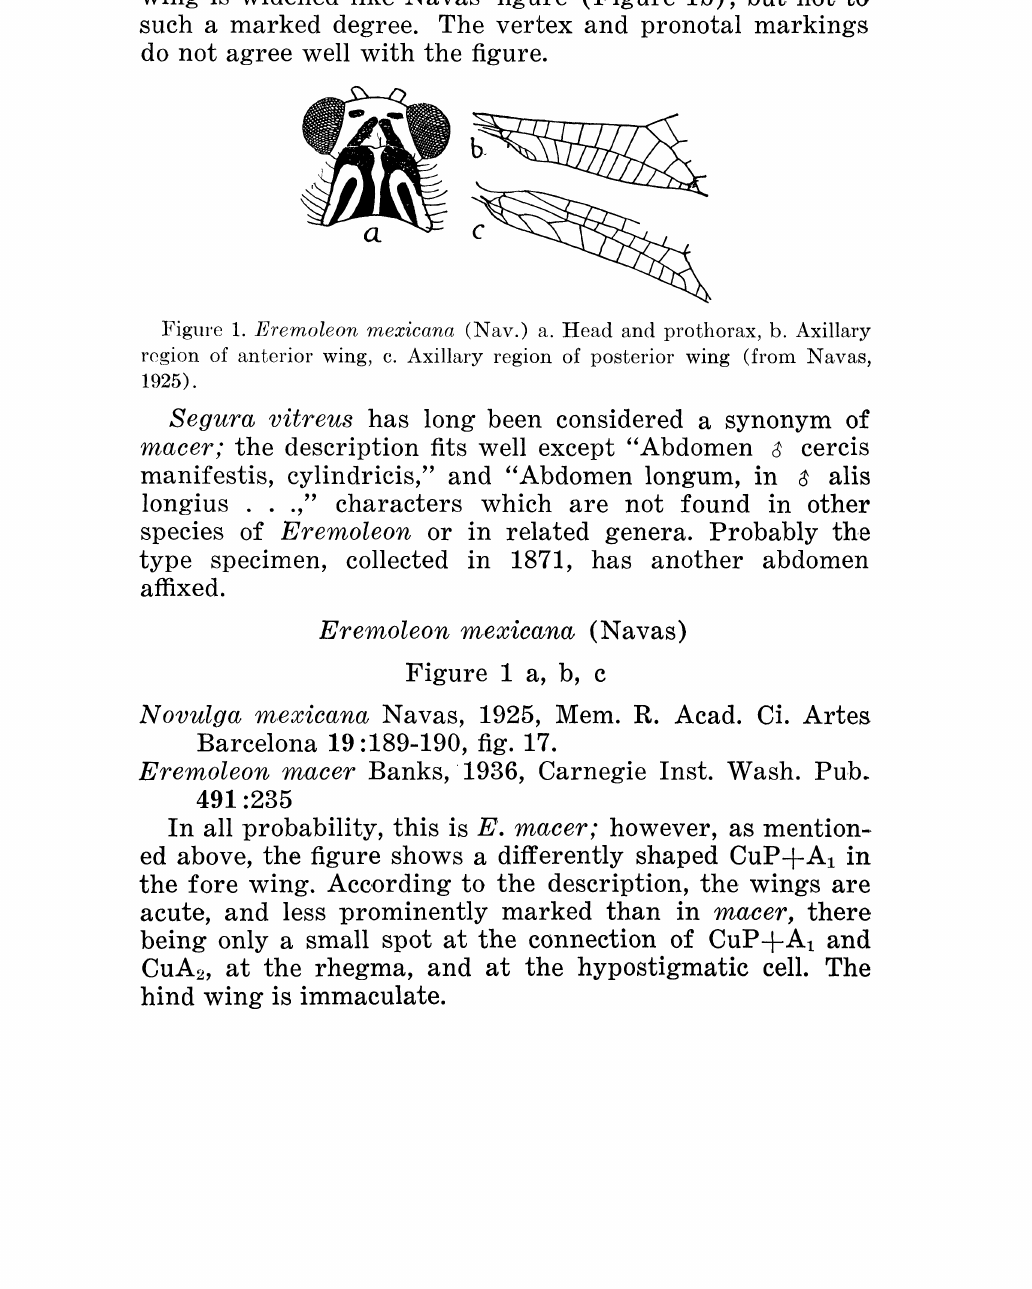
Figure 1. Eremoleon mexicana (Nay.) a. Head and prothorax, b. Axillary region of anterior wing, c. Axillary region of posterior wing (from Navas,